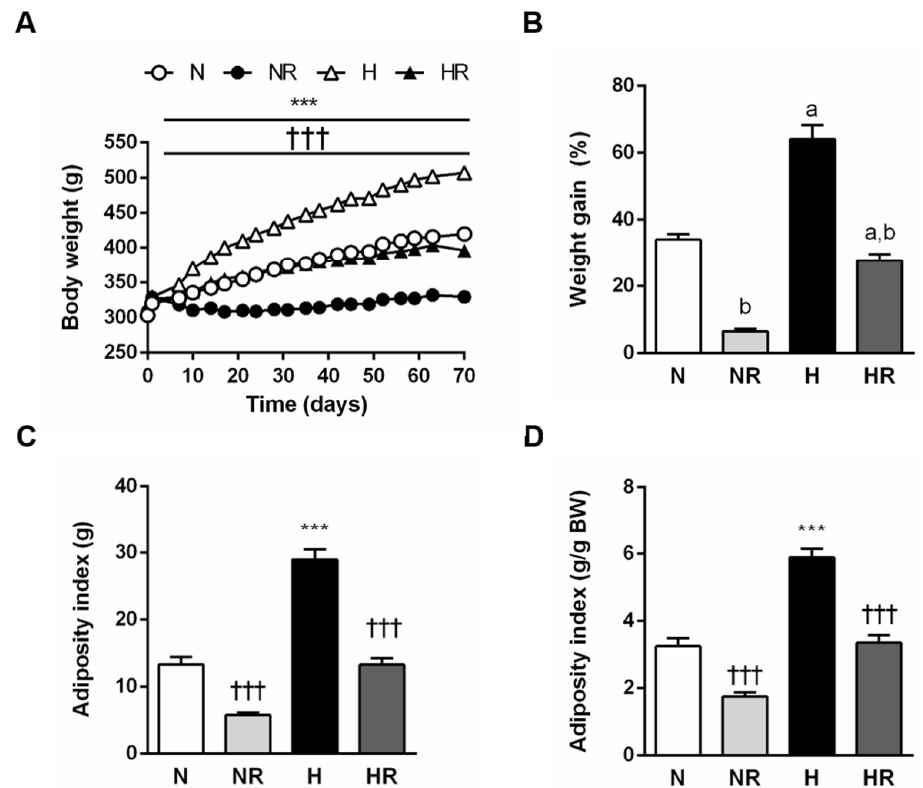
Figure 1. Growth curves of body weight ( A ), percentage of weight gain ( B ) and whole-body adiposity in absolute ( C ) and relative ( D ) values of the four experimental groups during the 9 weeks of dietary interventions. a p < 0.05 effect of diet; b p < 0.05 effect of caloric restriction. *** p < 0.001 vs. the same group fed a ND; ††† p < 0.001 vs. the same group fed ad libitum.